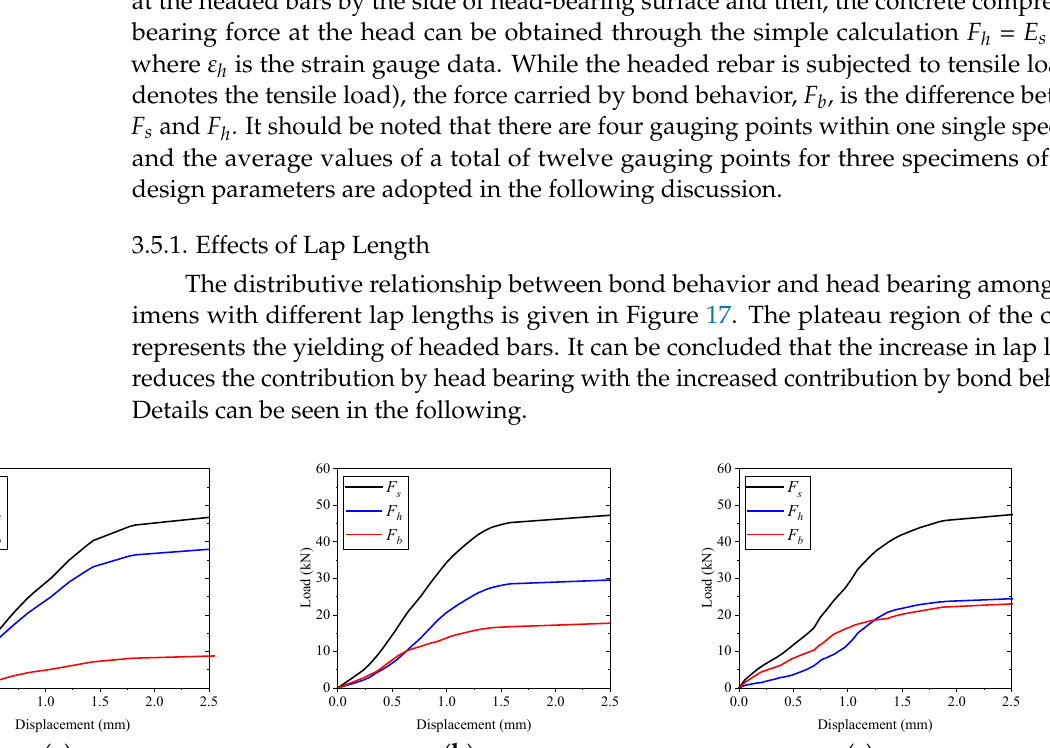
Figure 16. Stirrup skeleton after the test.